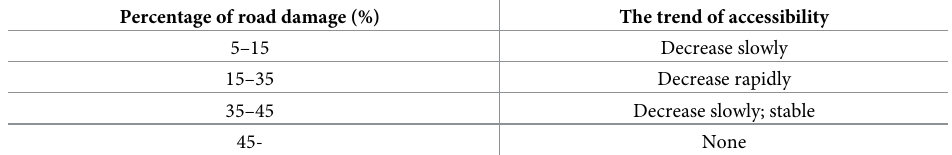
Table 12. S-curve change trend of spatial accessibility of 65–38.